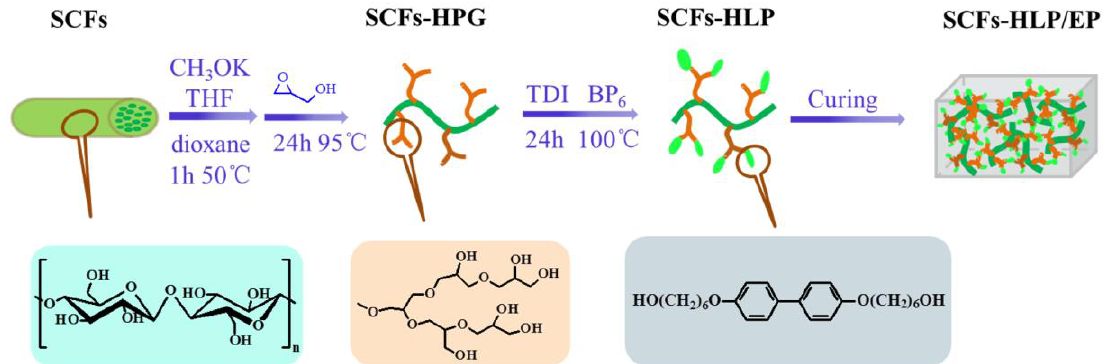
Scheme 1. The schematic of the preparation of hyperbranched liquid crystals modified sisal cellulose fibers/epoxy resin (SCFs-HLP/EP)